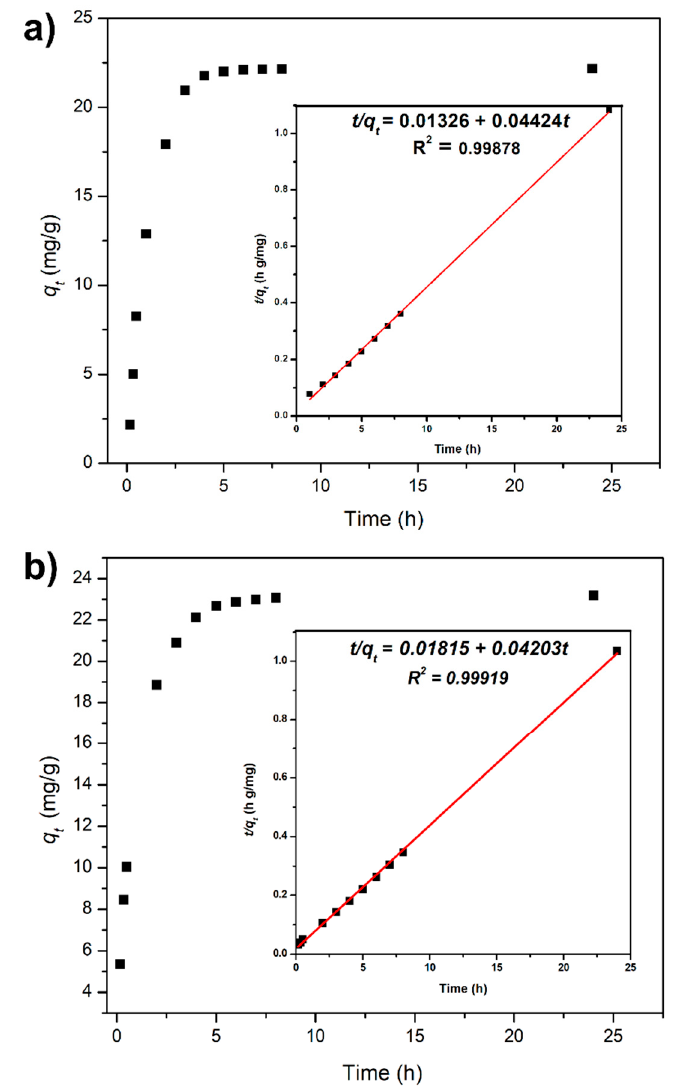
Figure 9. Adsorption kinetics of ( a ) cellulose treated with chitosan (Com-3), and ( b ) cellulose treated with chitosan pyridine (Com-4). Inserts show the experimental data fitted to a pseudo-second-order kinetic model.